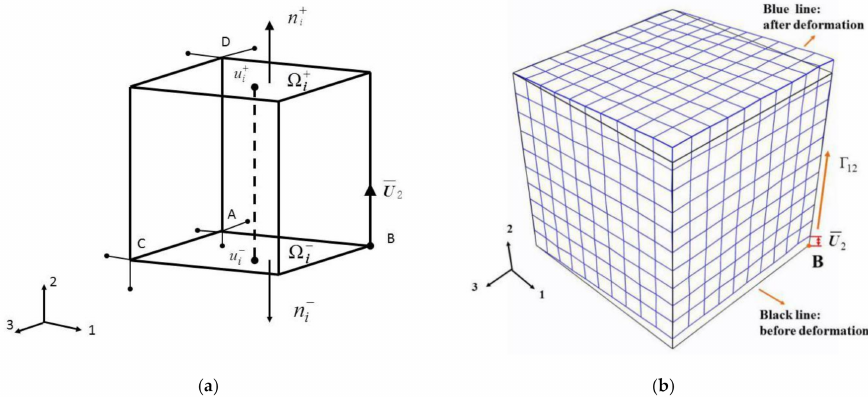
Figure 6. ( a ) Schematic diagram of representative volume element (RVE) boundary conditions; ( b ) RVE macroscopic deformation applied displacement U 2 at point